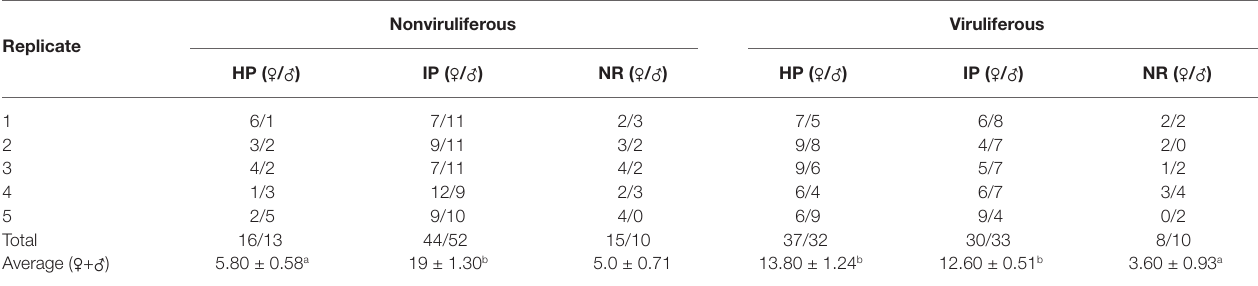
TABLE 1 | Selective responses of viruliferous and nonviruliferous R. dorsalis adults to volatiles from RGDV-infected and uninfected rice plants. Nonviruliferous Viruliferous Replicate HP ( ♀ / ♂